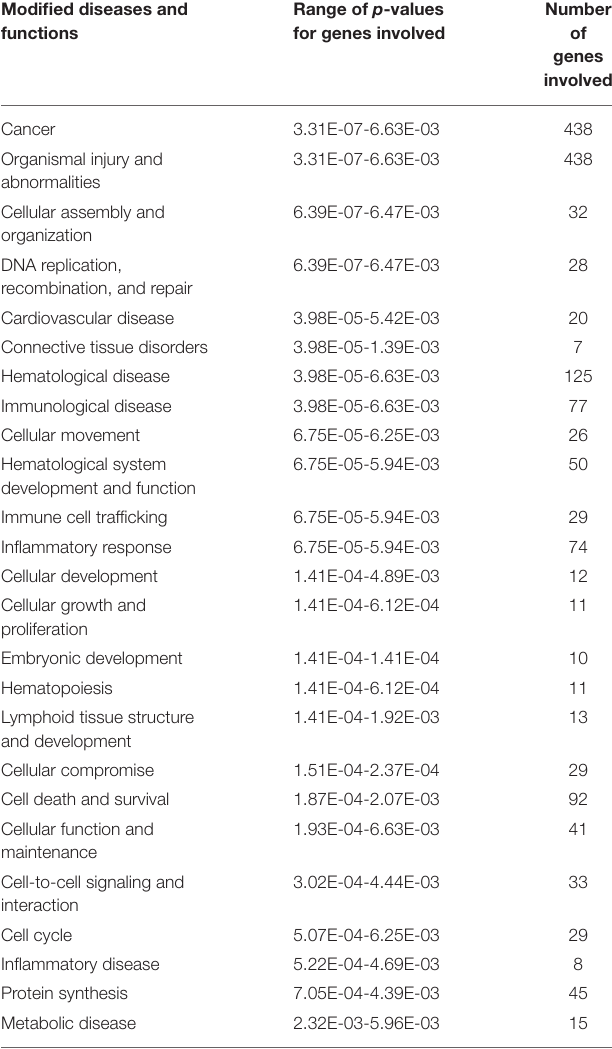
TABLE 4 | Modified diseases and functions obtained from ingenuity pathway analysis for the differentially expressed genes between Covid and control group. Modified diseases and